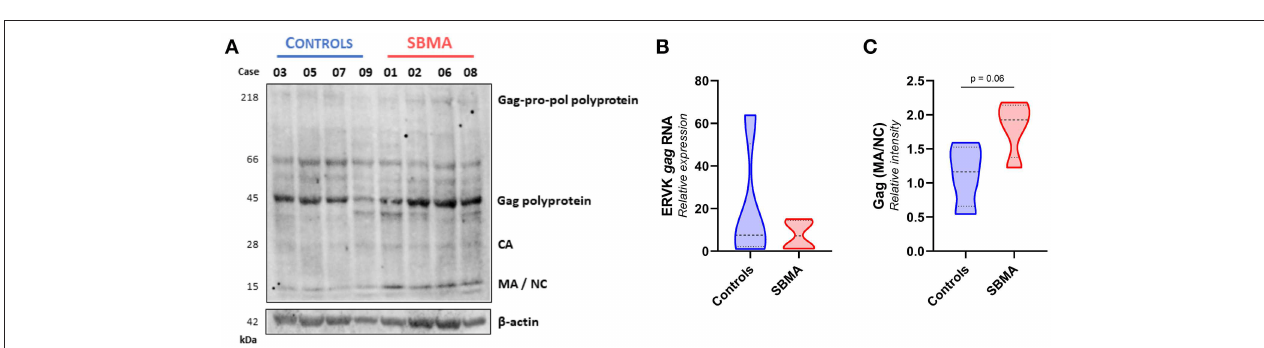
FIGURE 2 | Patients with SBMA exhibit increased levels of mature ERVK Gag proteins. (A) Ex vivo PBMC from controls ( n = 4) and patients with SBMA ( n = 4) were evaluated for protein expression of ERVK Gag polyproteins and mature viral protein isoforms, capsid (CA), matrix (MA), and nucleocapsid (NC). Notable cleavage of ERVK polyproteins into mature protein forms occurs to a greater extent in patients with SBMA than controls. SBMA patients had 60, 58, 52, and 55 CAG repeats in their androgen receptor gene, respectively (left to right). Endogenous β -actin was used as a loading control. (B) Similar ERVK gag transcript expression in control and SBMA cases. (C) Relative quantification of Gag MA/NC bands revealed a trend toward increased processed structural viral protein expression between controls and patients with SBMA, with p = 0.06. Violin plots depict measured values from individual patients and the probability density of the grouped data.